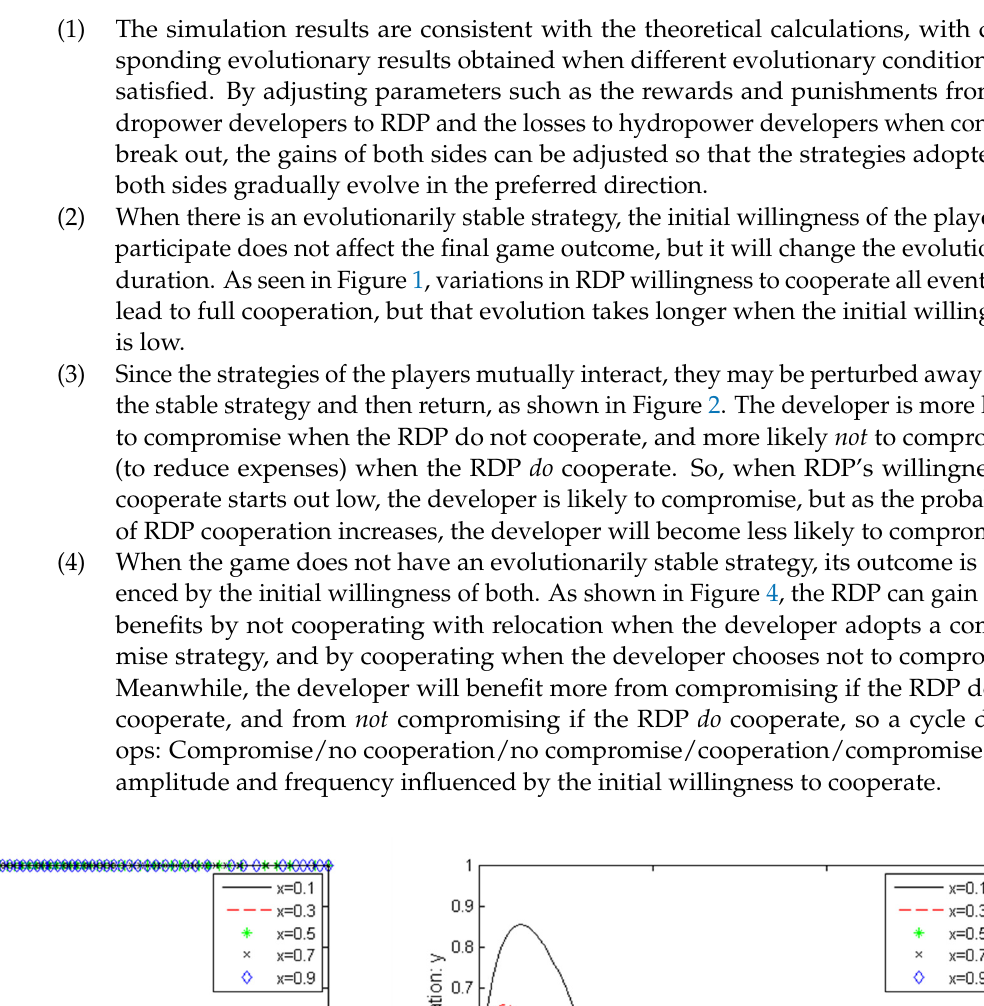
Figure 2. Evolution simulation, Scenario 2: ( a ) RDP; ( b ) hydropower developer.